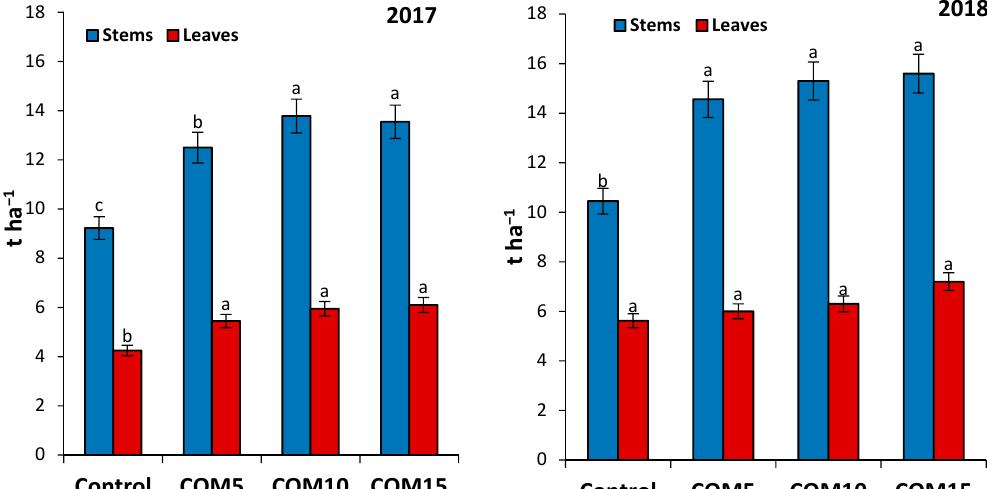
Figure 2. Effect of compost on the leaves and stems yield (tons ha − 1 ) of river saltbush plants. COM 5 = 5 t of compost ha − 1 , COM 10 = 10 t of compost ha − 1 , and COM 15 = 15 t of compost ha − 1 . Means ( ± SD) symbolized by different letters refer to significant differences based on Duncan’s test at p < 0.